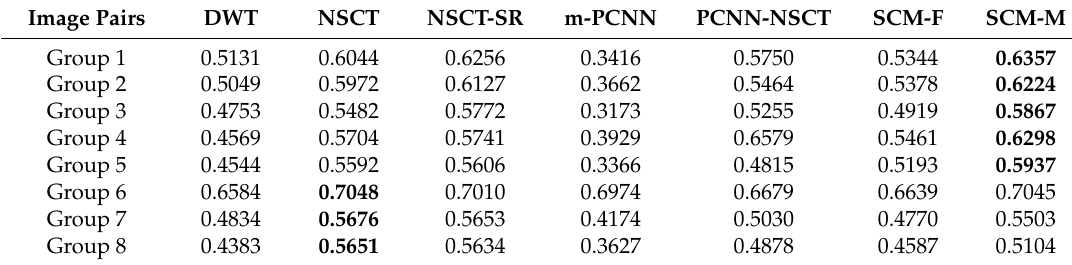
Table 2. Q E for the seven methods operating on the eight groups of medical